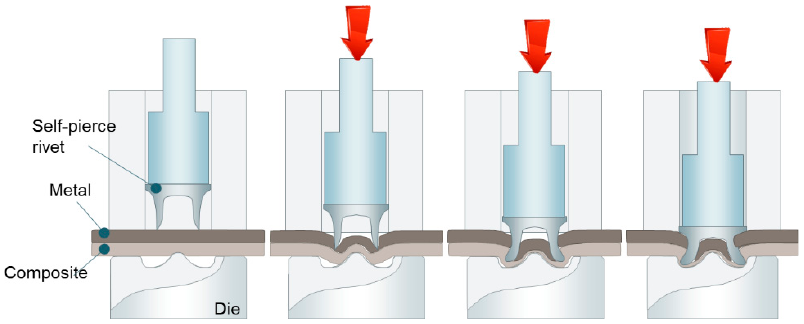
Figure 6. Schematic of the SPR joining process.